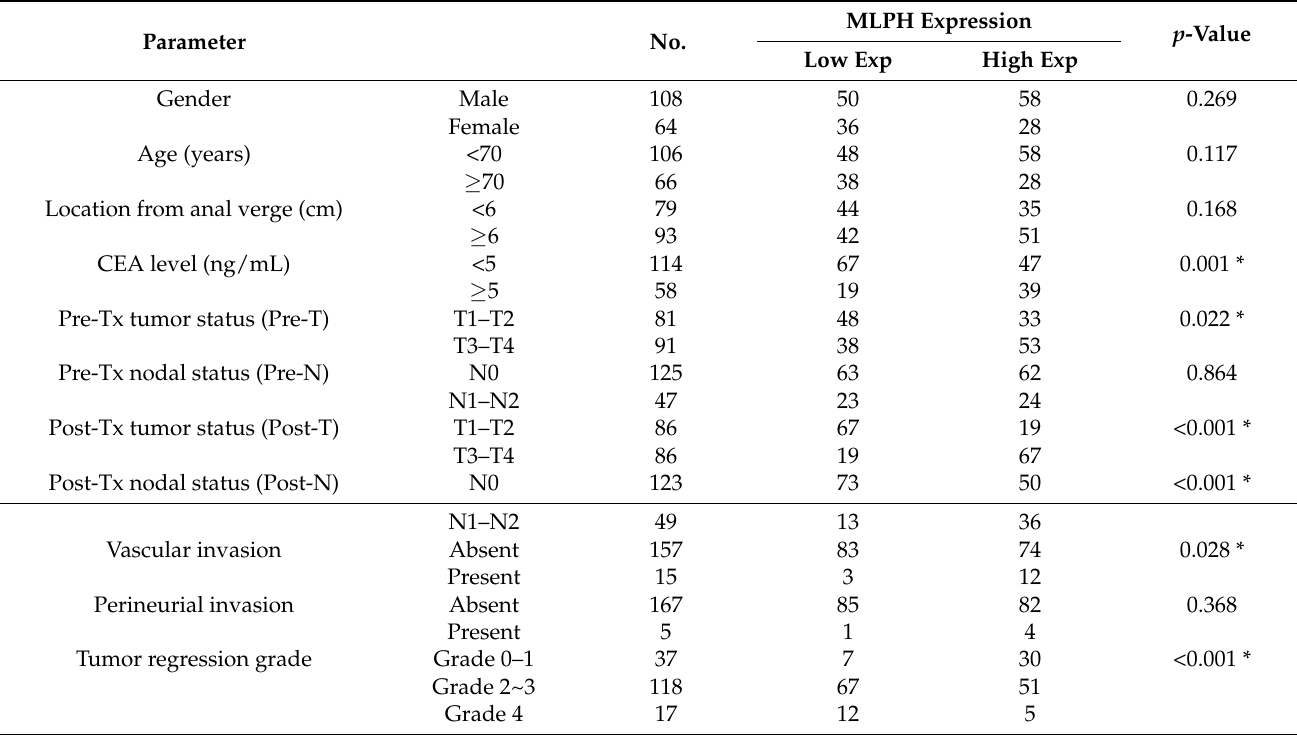
Figure 1. Analysis of gene expression in chemoradiation responders versus non-responders from a published transcriptomic dataset of rectal cancers (GSE35452). Tissue specimens from responders (yellow lines) and non-responders (blue lines) are indicated on top of the heatmap, and expression levels of up-regulated and down-regulated genes are expressed as a spectrum of brightness of red and green. Melanophilin (MLPH) was identified as the most significantly upregulated gene related to intracellular protein transport (GO:0006886). Table 2. Associations and comparisons between MLPH expression and clinicopathological factors in 172 rectal cancer patients receiving neoadjuvant